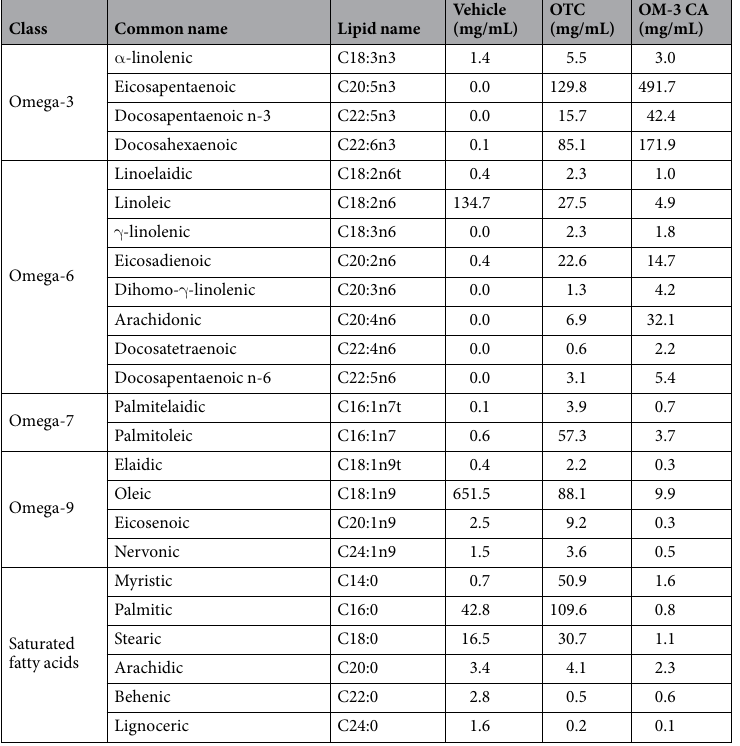
increase in efficacy for most endpoints, no exposure–response relationship between OTC OM-3-triglycerides and the endpoints was observed, possibly owing to the limited amounts tested. Palmitic acid can play a pro-inflammatory role.